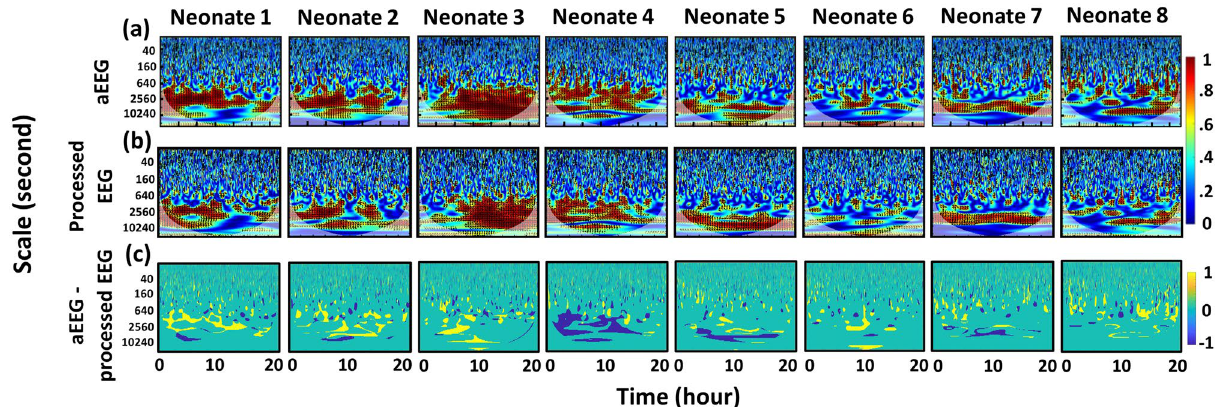
Figure 2. Time-scale coherence maps of NVC in the selected cohort. The x-axis represents time in hours, the y-axis represents scale in seconds, and the color scale represents the amplitude of WTC coherence, R 2 . The areas with significant NVC (p < 0.05) are contoured with black lines and filled by red color in each panel. Top and bottom rows correspond to WTC-based SctO2-aEEG and SctO2-processed EEG coherence (R 2 ), R SctO2 → aEEG and R SctO2 → processed EEG , for each case (Neonate #: N1-N8). For each panel of the top row, aEEG tracings were derived using WU-NEAT method 7 ; for each panel of the bottom row, processed EEG tracings were obtained by